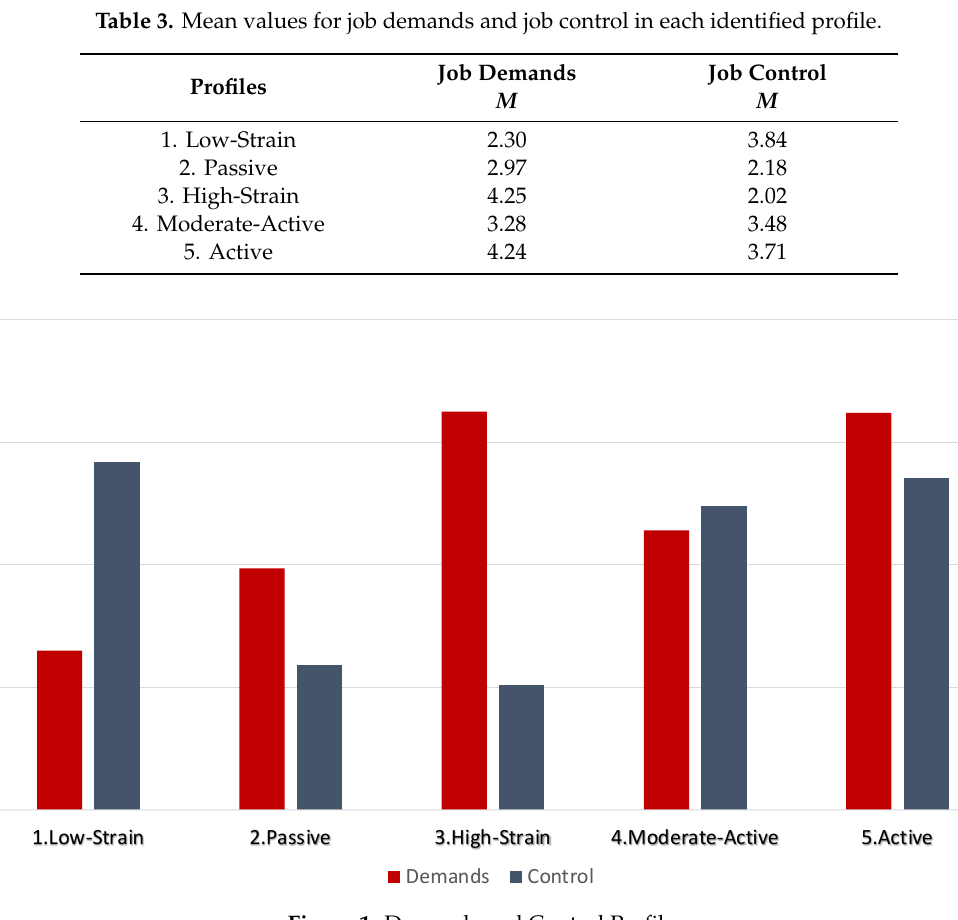
Figure 1. Demands and Control Proflles